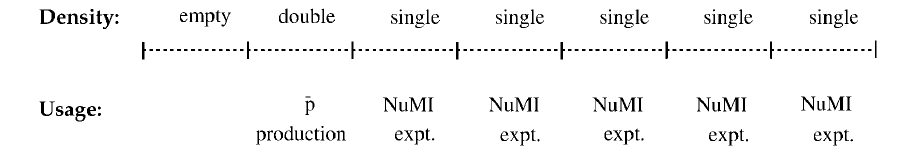
FIG. 1. The Main Injector in Run IIb accelerates five single-density booster batches for the NuMI neutrino experiment and one double-density booster batch for antiproton production. One booster-batch length is left empty for the kickers. At the injection energy of E (cid:1) 8.939 GeV, one booster-batch length is T b (cid:1) 1.59 m s and the revolution period of the Main Injector is T 0 (cid:1) 7 T b (cid:1) 11.13 m s. TABLE I. Some injection parameters of the Fermilab Main Injector. Nominal total energy E (GeV)